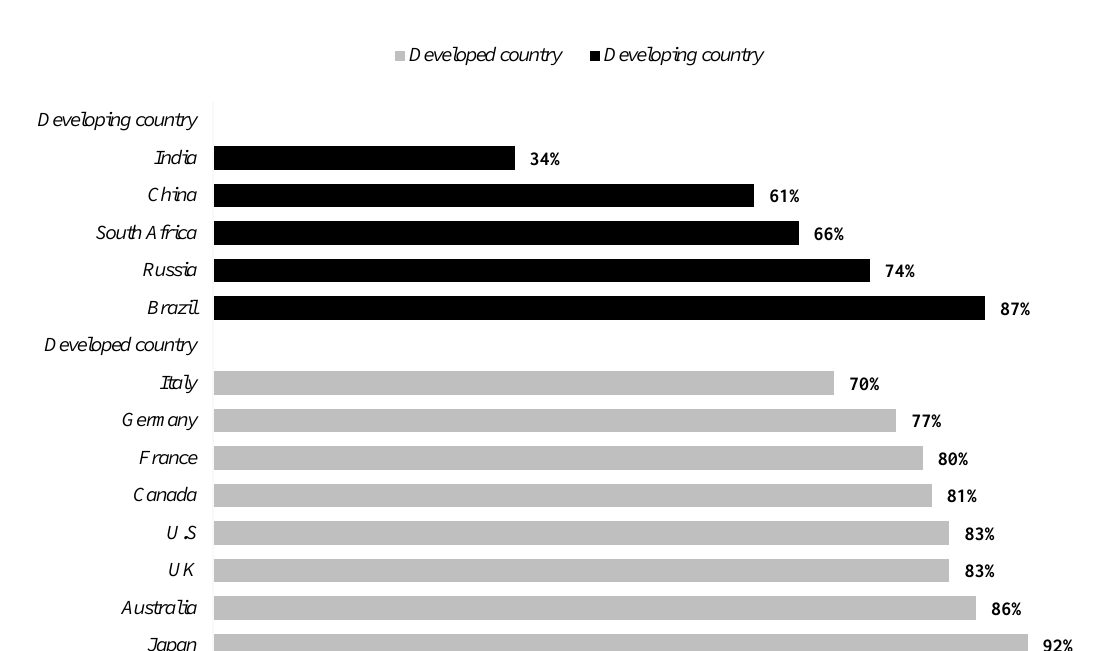
Figure 1. The stage of urbanization in some countries of the world in 2019.